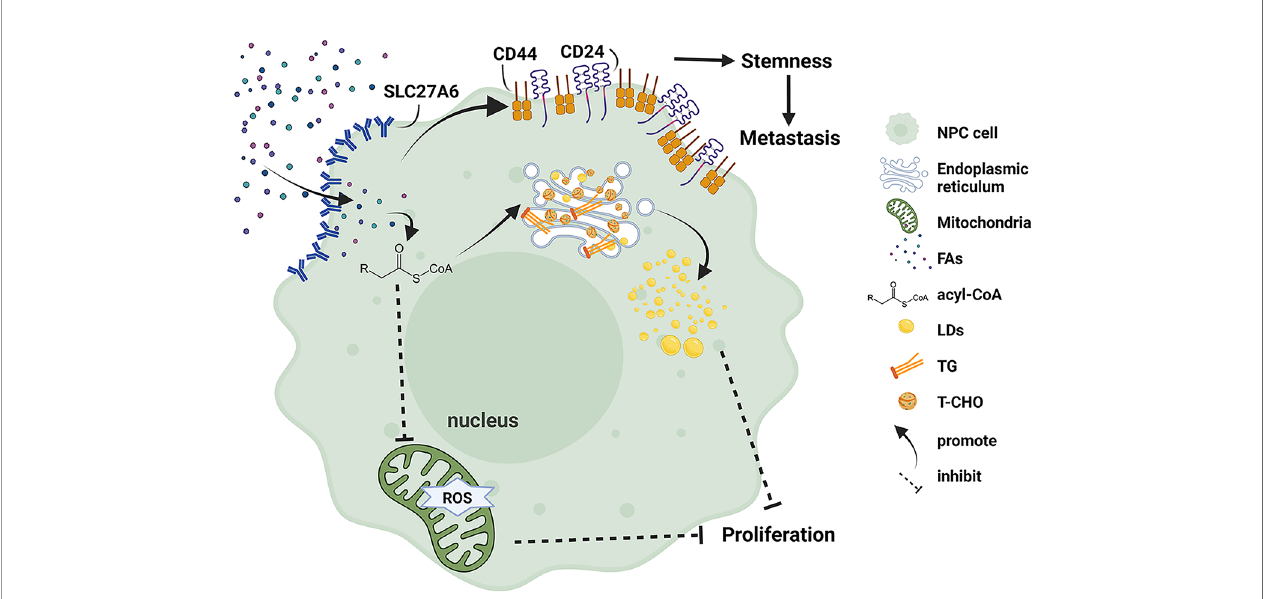
FIGURE 8 | Schematic model illustrating the function of SLC27A6 regulates lipid metabolism in NPC. Re-expression of SLC27A6 increases free FAs uptake of NPC cells. After free FAs are absorbed, they bind to coenzyme A to inform acyl-CoA and convert to TG and T-CHO in the endoplasmic reticulum. In addition, TG and T- CHO are composed of LDs in the cytoplasm. LD storage within cells inhibited tumorigenesis in vitro and in vivo . However SLC27A6 decreases the level of ROS produced in mitochondria. On the other hand, excessive FAs upregulate the expression of CSC markers (CD24, CD44), maintaining the stemness of NPC CSC and contributing to